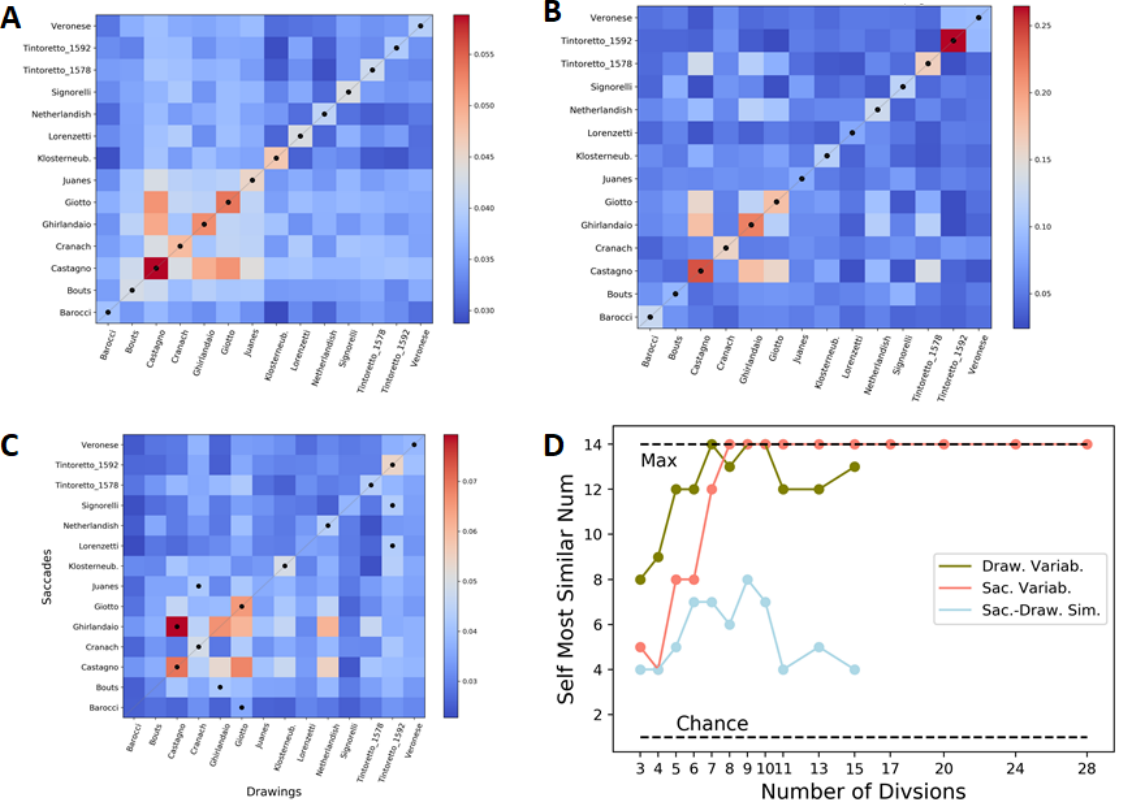
Figure 2. Comparison across paintings as method validation. The similarity across different paintings is shown on A-C, with black dots marking the most similar painting for each row (red = higher similarity). A) Saccade Variability. Eg: the 14 cells in the first row represent similarity between all saccades of the Veronese painting compared to all of the saccades for each of the 14 paintings (across different observers). B) Drawing Variability, the same as A but for drawings. C) Saccade-Drawing Similarity (x- axis: drawings, y-axis: saccades). Cells in the first row show the similarity of all saccades for the Veronese compared to the compo- sitional drawings of all 14 paintings. D) This figure shows the combined number of self-similar paintings (number of black dots falling on diagonal in A-C) for the 3 measures for the different number of divisions (x-axis), where the most similar set of sac- cades/drawings are the ones for the same